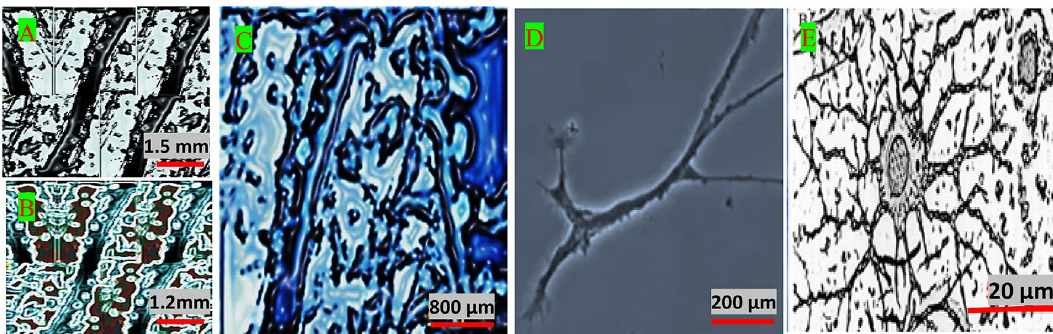
Figure 1. ( A )–( D ) Inverted super-resolution fluorescence microscopic images and ( E ) high-resolution cryo- TEM image of the differentiated neuron stem cell immobilized into the micro-channels inside the PTFE Petri